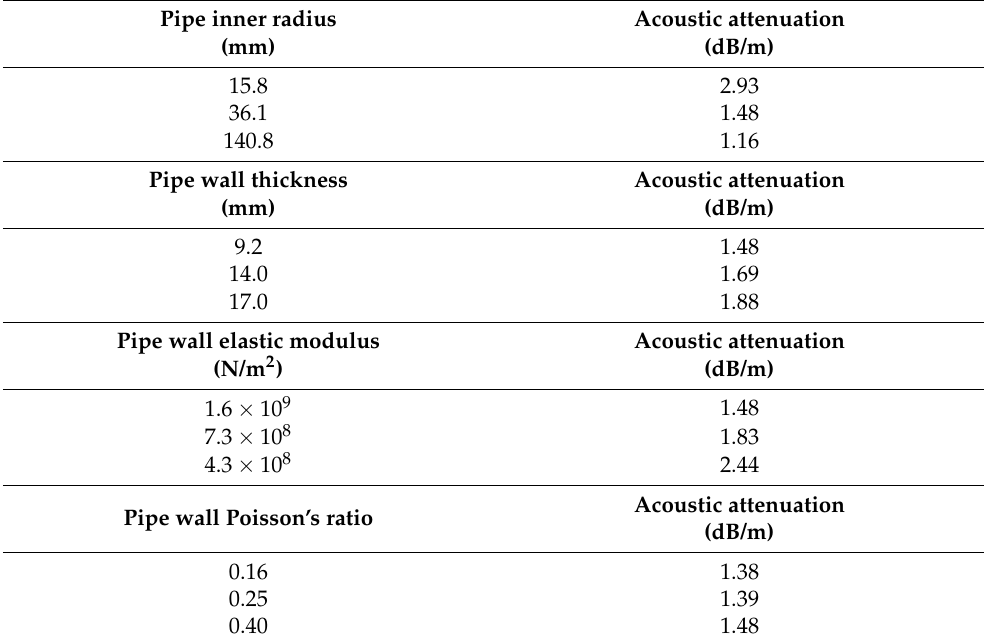
Table 4. Numerically predicted acoustic attenuation along the exposed MDPE pipe with respect to change in pipe inner radius, wall thickness, elastic modulus of the pipe and Poisson’s ratio of the pipe